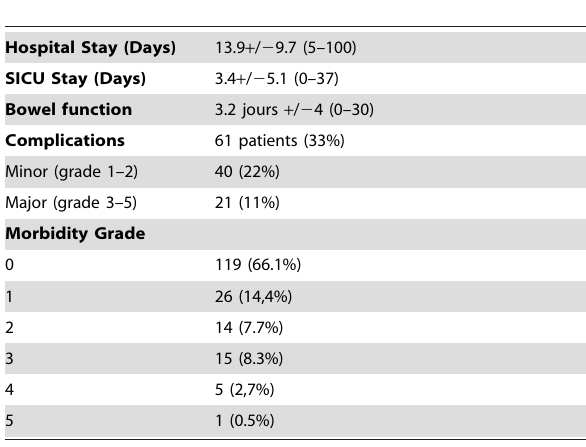
Table 3. Post-operative parameters.